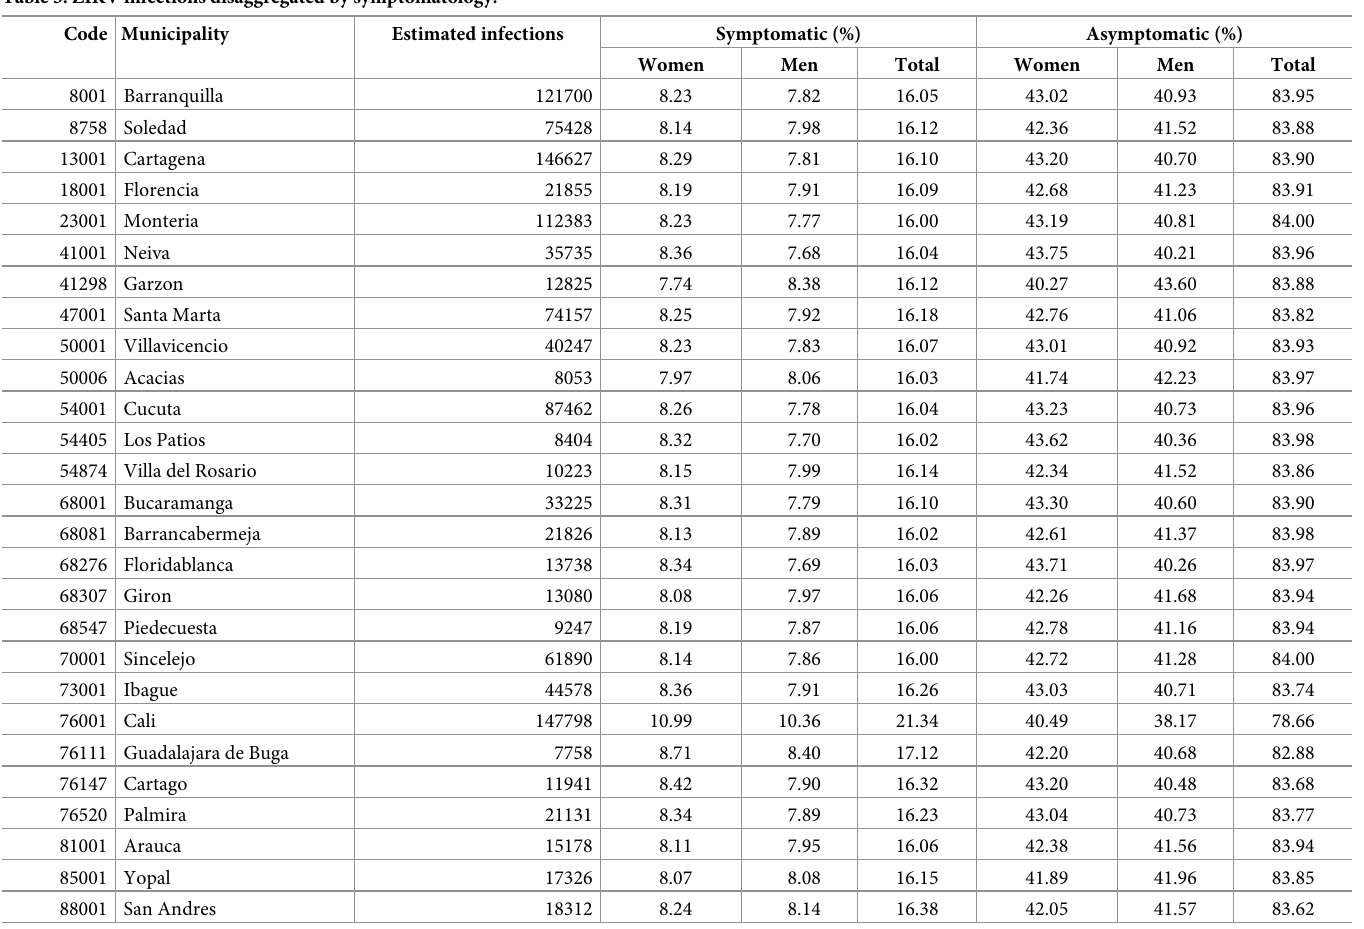
Table 5. ZIKV infections disaggregated by